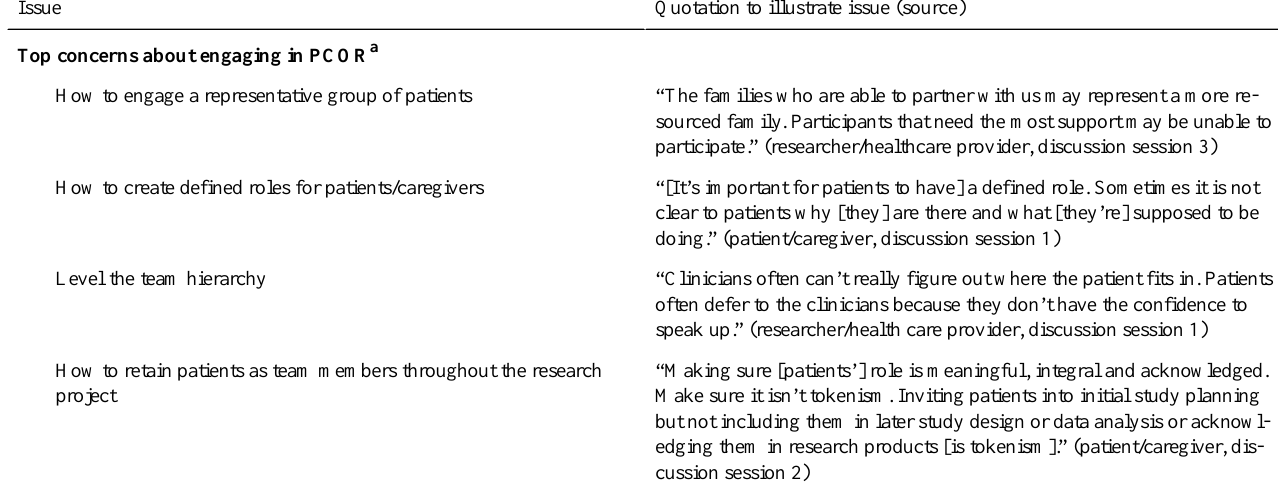
Table 4. Top 4 priorities related to concerns about engaging in PCOR and PCOR training topics and skills from World Café discussion sessions. Quotation to illustrate issue